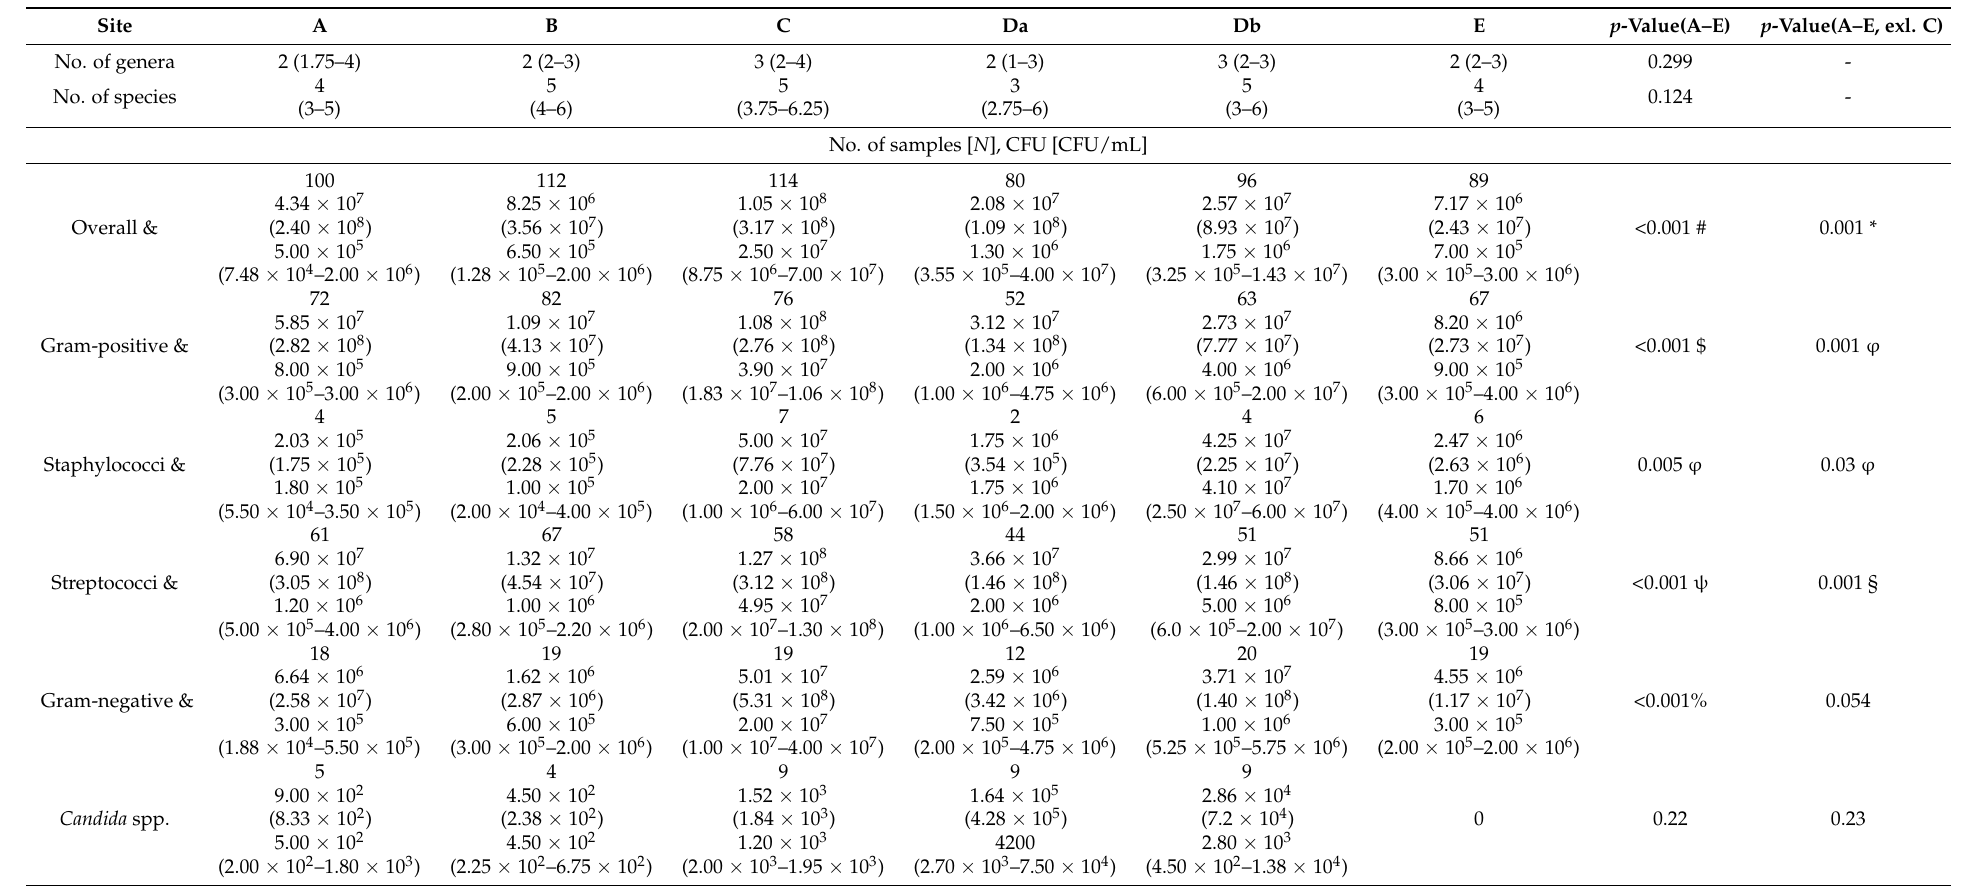
Table 2. Characteristics of sites